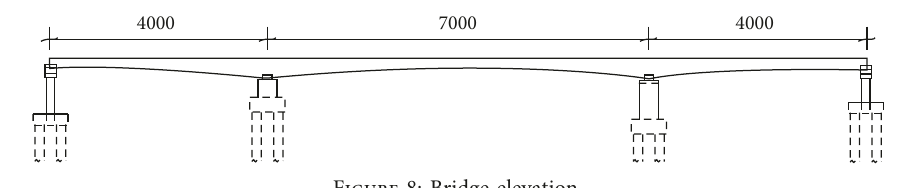
Figure 8: Bridge